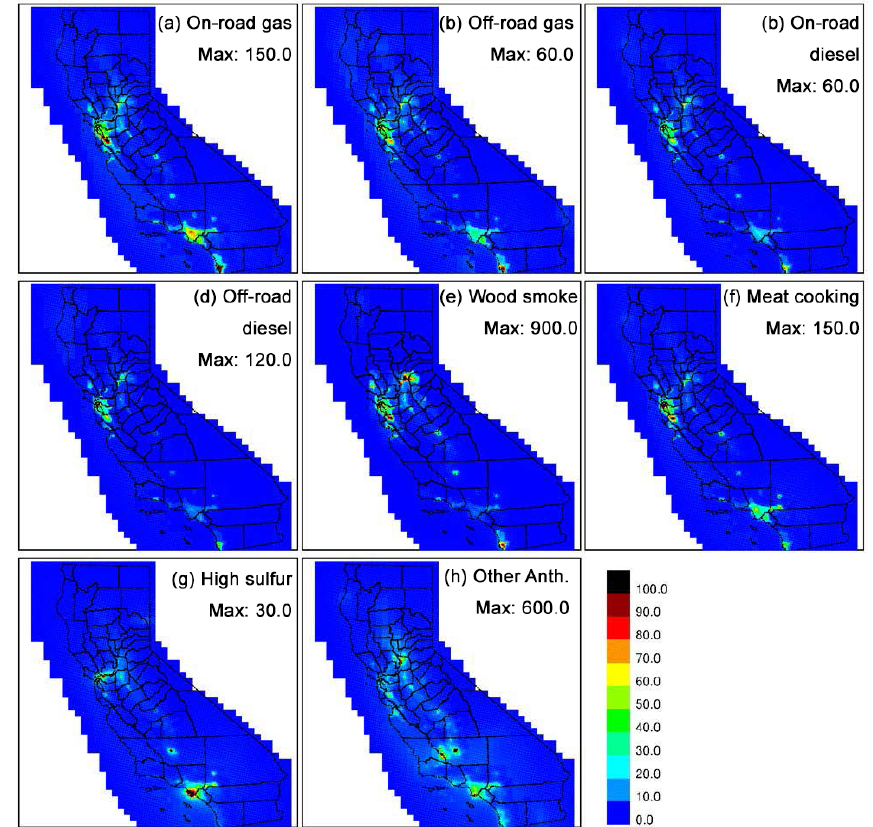
Figure 7. Predicted source contributions to 9-year average PM 0 . 1 POA concentrations. The color scales (shown in the last panel in unit of %) indicate the ratio of the concentrations to the maximum 9-year average concentration values, which are shown in the panels under source names with a unit of ngm − 3